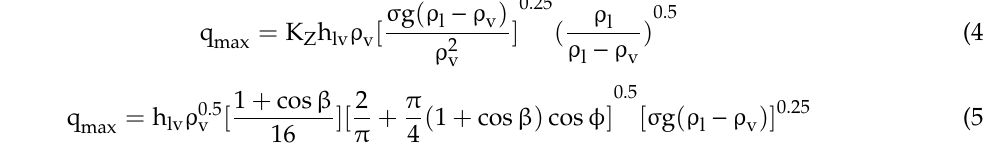
Figure 6. Field-emission scanning electron microscopy (FESEM) pictures of applied nanoparticles, ( a ) ZnO; ( b ) Al 2 O 3 , and SEM of ( c ) carbon nanotubes (CNTs) [80]. Neto [76] et al. studied the boiling heat transfer performance of water-based Fe 2 O 3 , Al 2 O 3 , and CNTs nanofluids on the copper surface at a volume concentration of 0.02% and 0.1%, and the deposition surface of Fe 2 O 3 , Al 2 O 3 , and CNTs after experiment on the deionized water. The CHF and Zuber correlation curves [109] and Kindlikar correlation curves [110] of different nanoparticle types were compared. The Zuber correlation curve and the Kindlikar correlation curve are as shown in Equations (4) and (5).